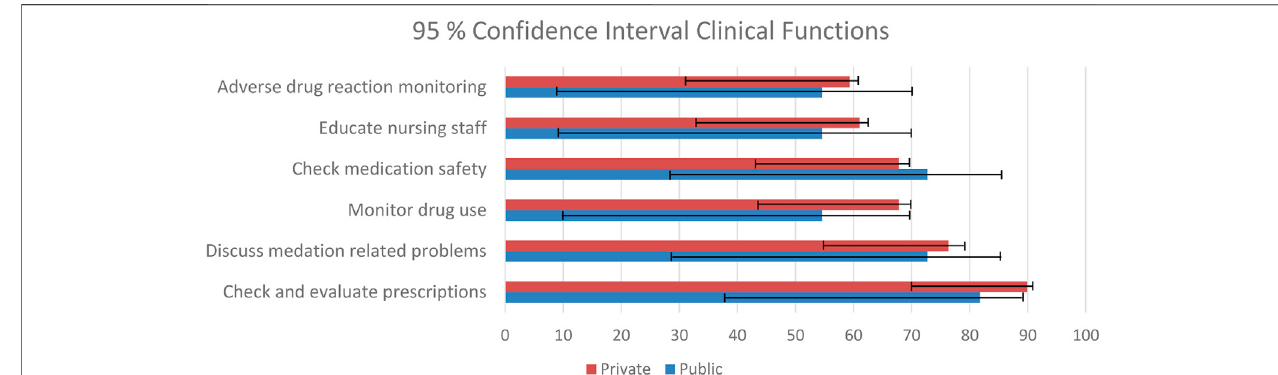
FIGURE 2 | Clinical functions.